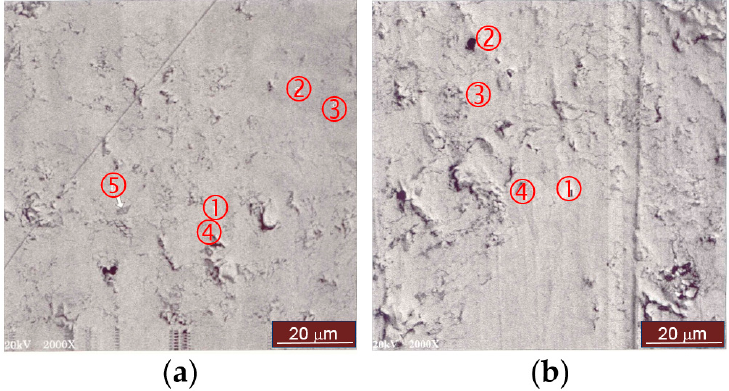
Figure 2. Scanning electron microscope (SEM) backscattering electron micrographs of ( a ) pristine, and ( b ) annealed alloy B. Table 1. Phase abundances (in wt %) of alloy B before and after annealing determined by the X-ray diffractometer (XRD) analysis. HEX, CUB, and RHO are hexagonal, cubic, and rhombohedral, respectively.